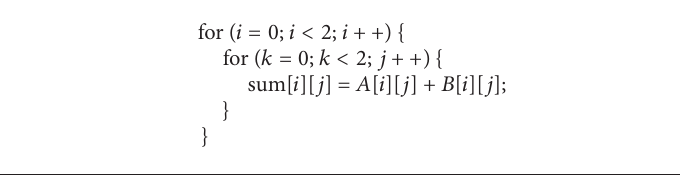
Algorithm 4: For-loop code for 2 × 2 matrix-matrix addition in C.